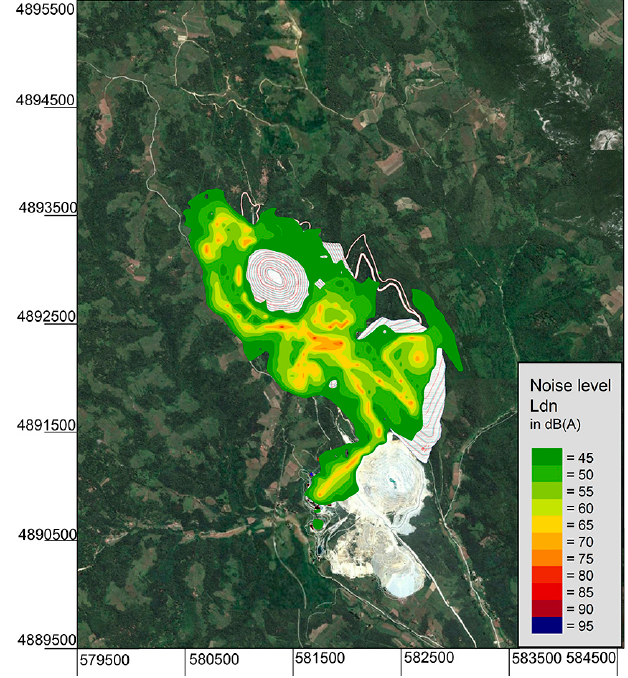
Figure 9. Noise propagation assessment around the Cerovo open pit mine.